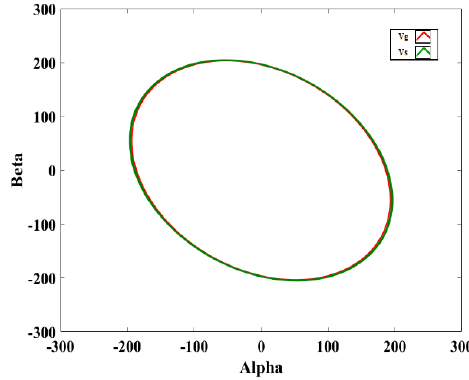
Figure 10. Grid and stator induced voltages in the stationary reference frame using proposed